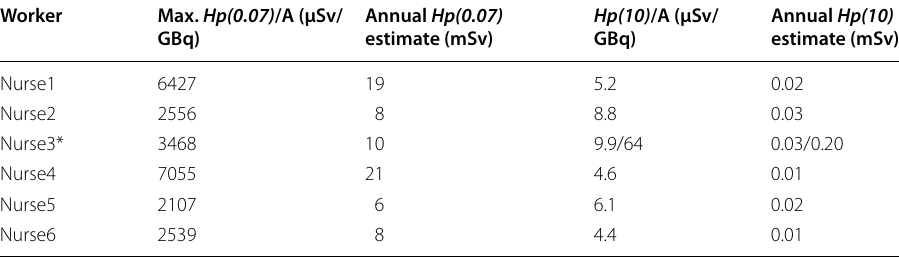
*Showing both Hp(10) obtained with PED and InLight